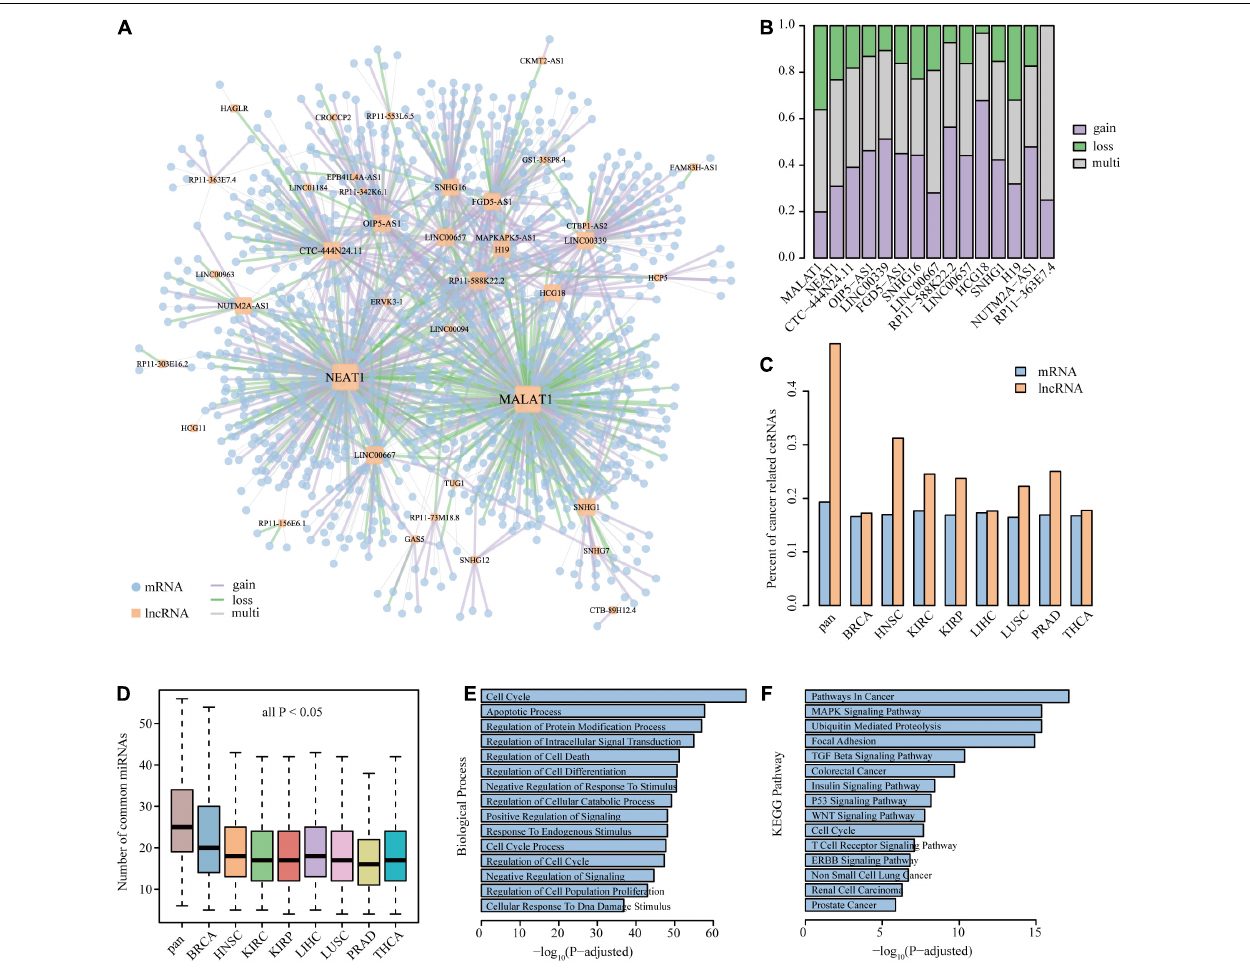
FIGURE 4 | The property and functional analysis of the core component. (A) The largest component of the core dysregulated ceRNA interactions. (B) The property of edge linked to lncRNAs in the core component. The assignment of lncRNAs was sorted by node degree in the core component. Only show the lncRNAs with a degree of more than 10 in the core component. (C , D) The comparison of the percent of cancer-related ceRNAs and the number of common miRNAs between the core component ceRNAs and single dysregulated network. (E , F) The biological process and KEGG pathway enriched by the genes in the core